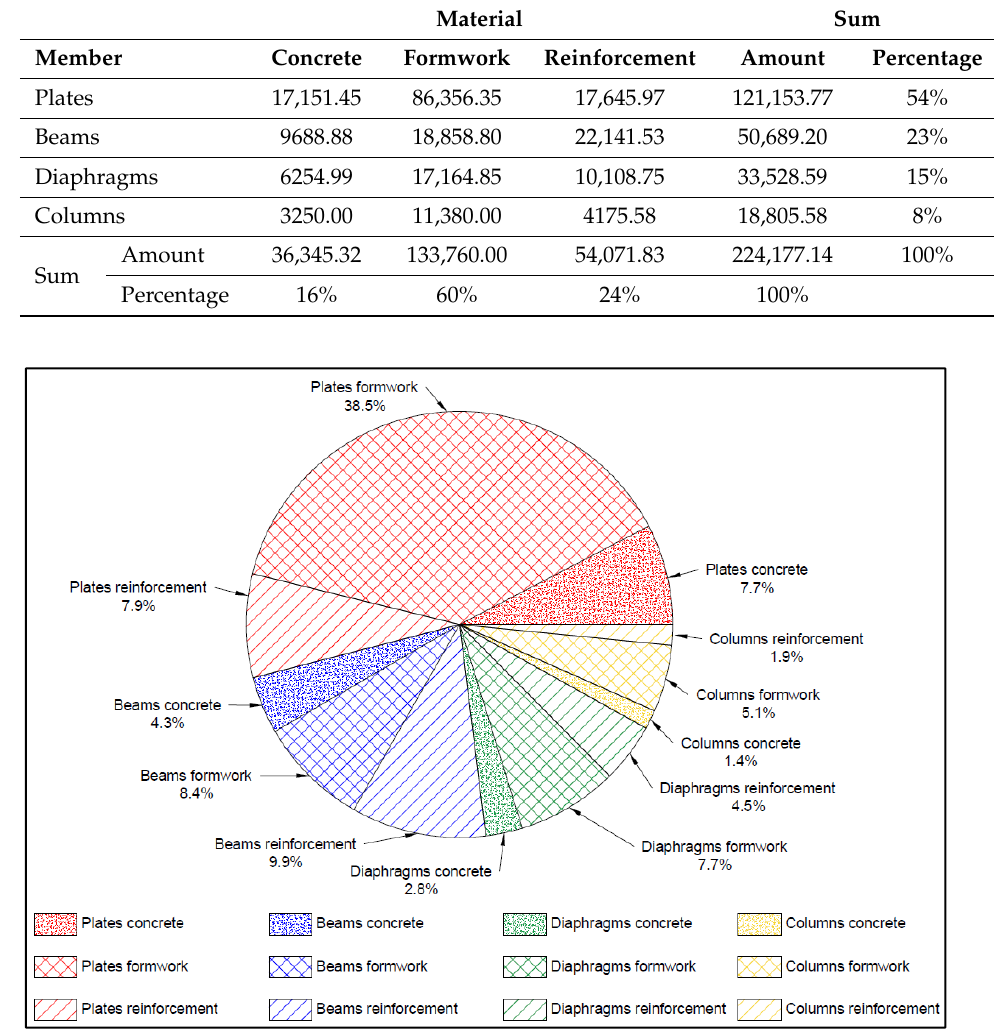
Table 20. Column’s constraints the maximum demand capacity ratio in the optimum designs achieved by each metaheuristic algorithm for the V-type folded plate roof building. Const.